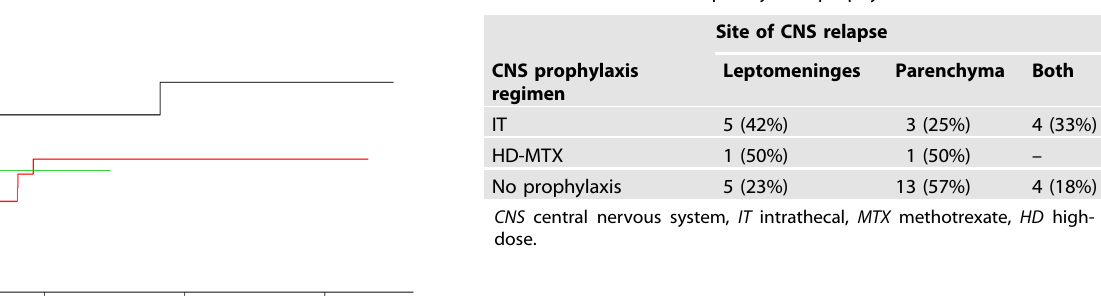
Table 2. Site of CNS relapse by CNS prophylaxis.